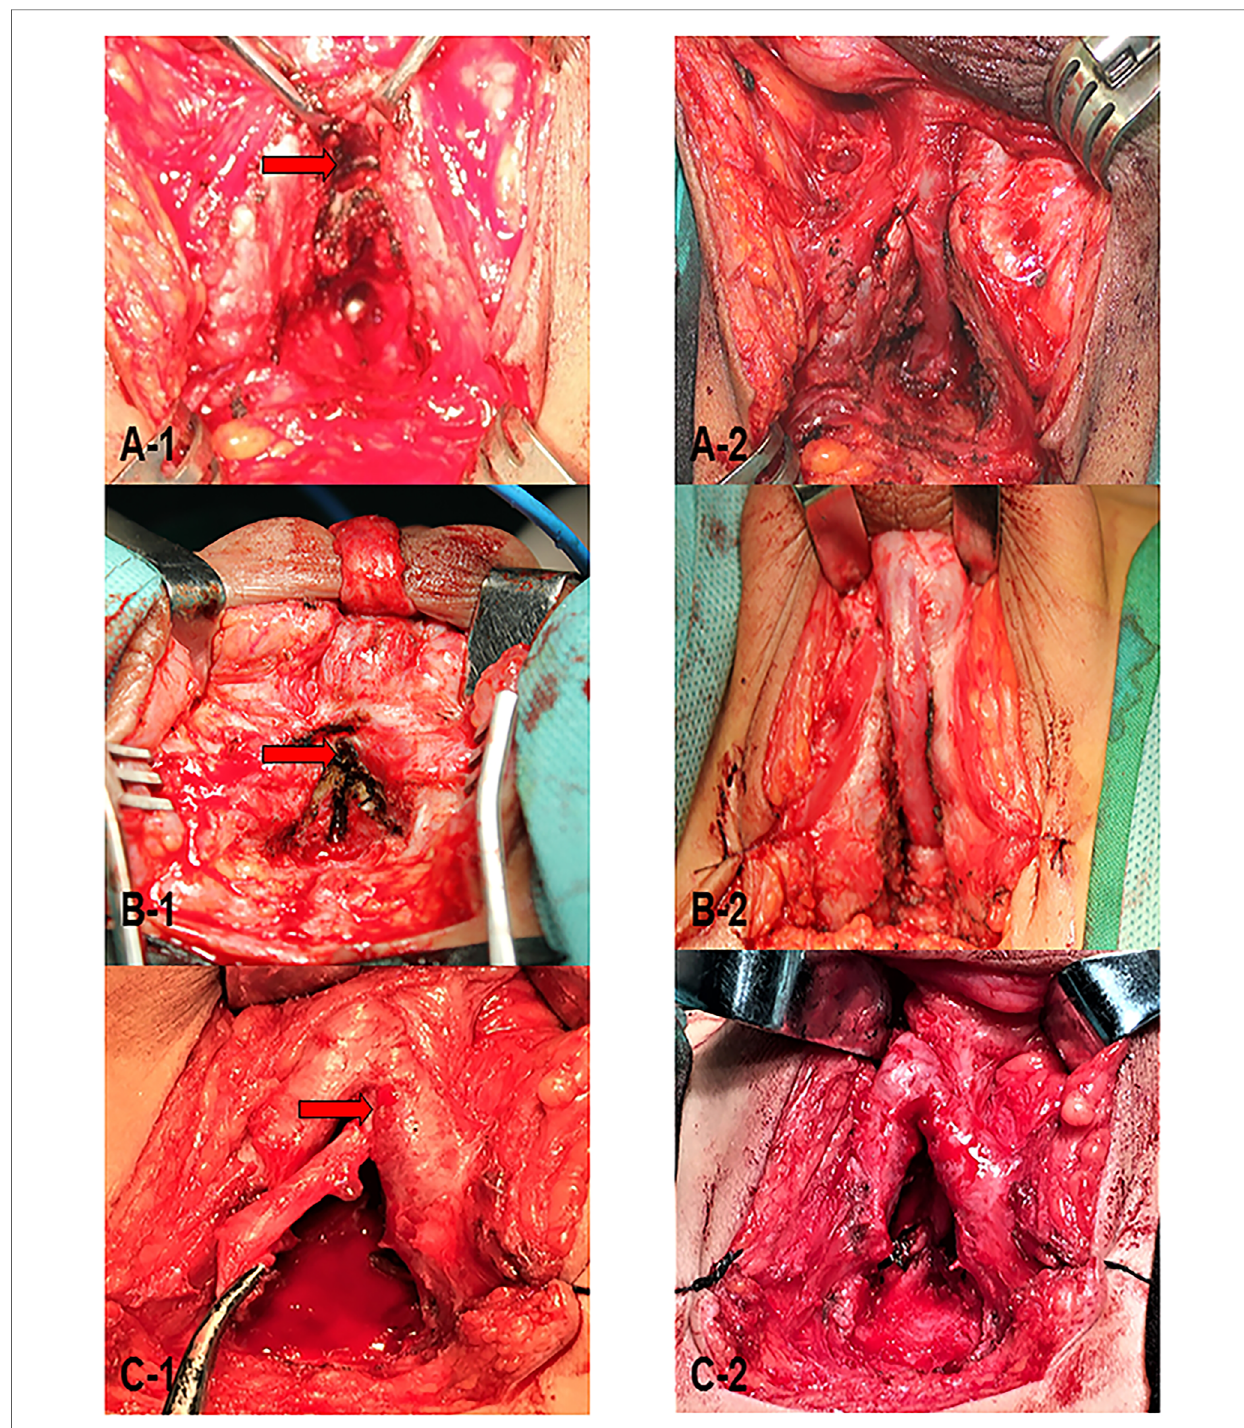
FIGURE 2 During the operation, on the basis of freeing the anterior urethra, perform ( A1-2 ): penile septum incision (pointed by arrow); ( B1-2 ): resection of the lower edge of the pubic symphysis (pointed by arrow); ( C1-2 ): urethral transposition to foot of the cavernous body of the side penis (pointed by the arrow) to achieve tension-free anastomosis of the distal and proximal